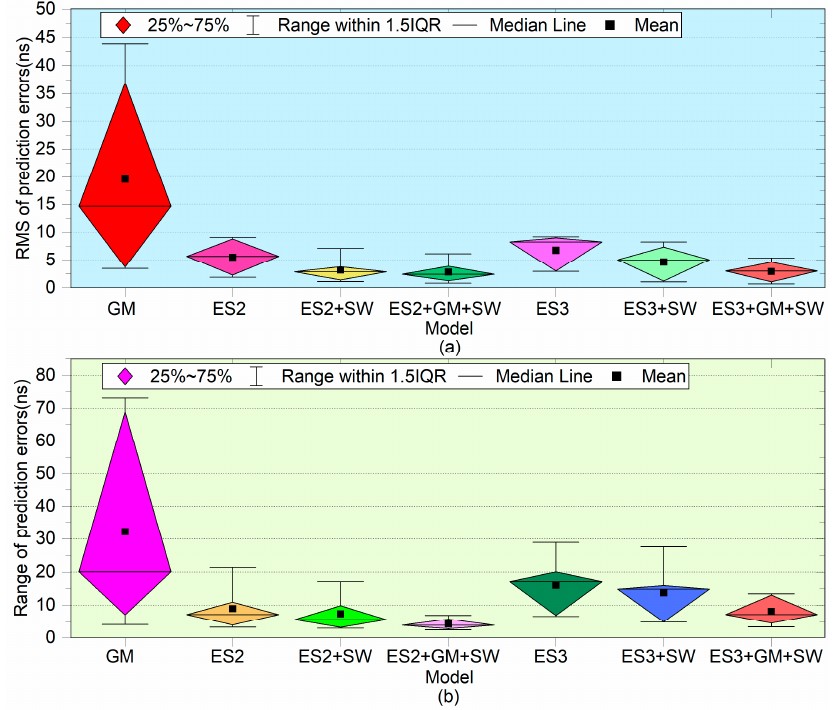
Figure 12. Boxplot change diagram of 24 h prediction accuracy ( a ) and stability ( b ) using different models.